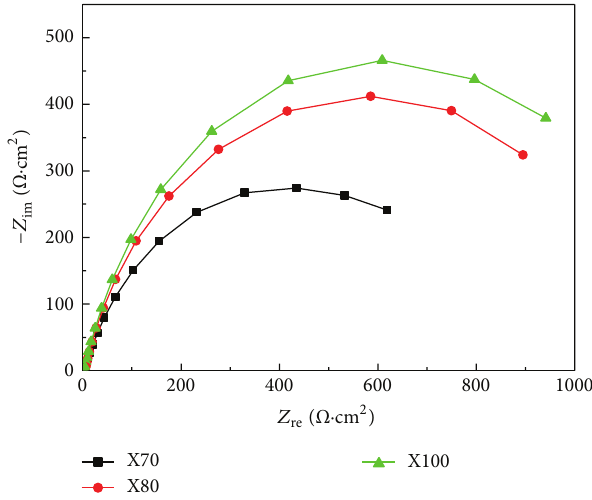
Figure 2: Nyquist plots of passive films for X70, X80, and X100 pipeline steels in 3.5 wt.% NaCl